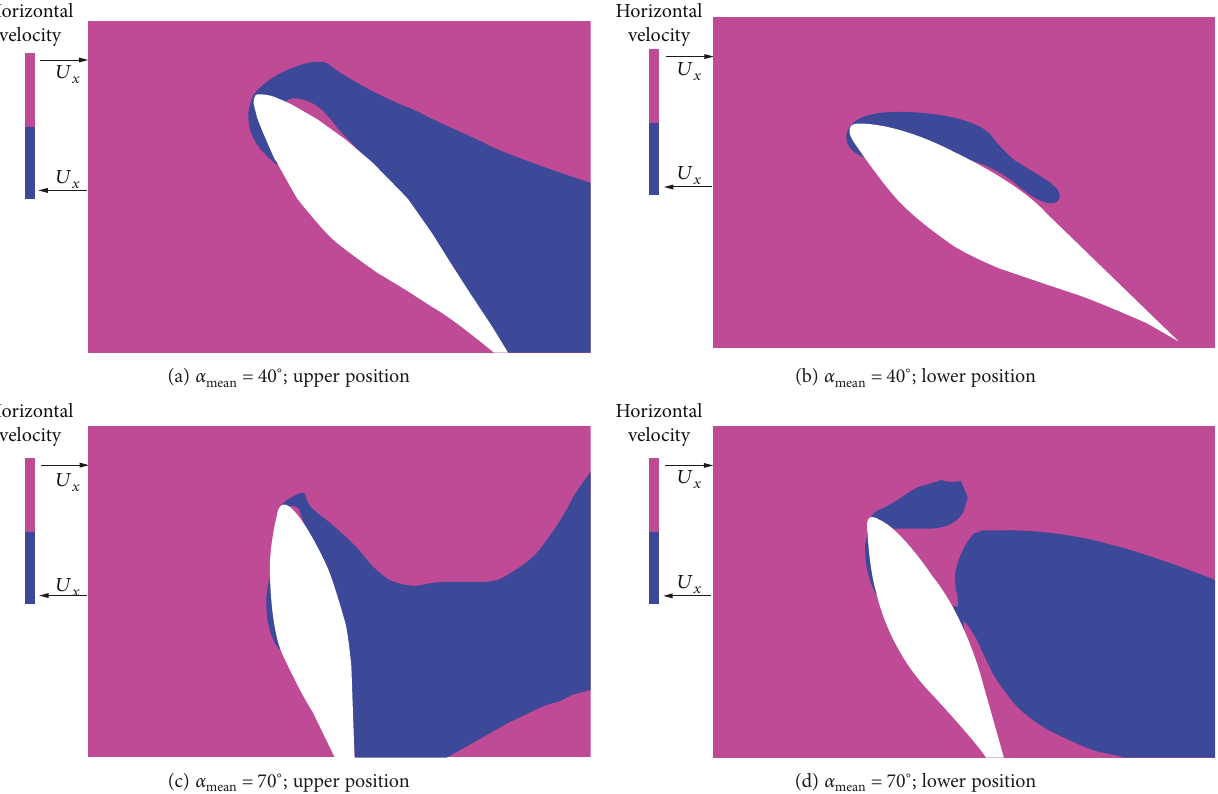
Figure 9: Instantaneous horizontal velocity showing the fl ow reattachment point on the leading edge for α on their max and min pitching position ( α